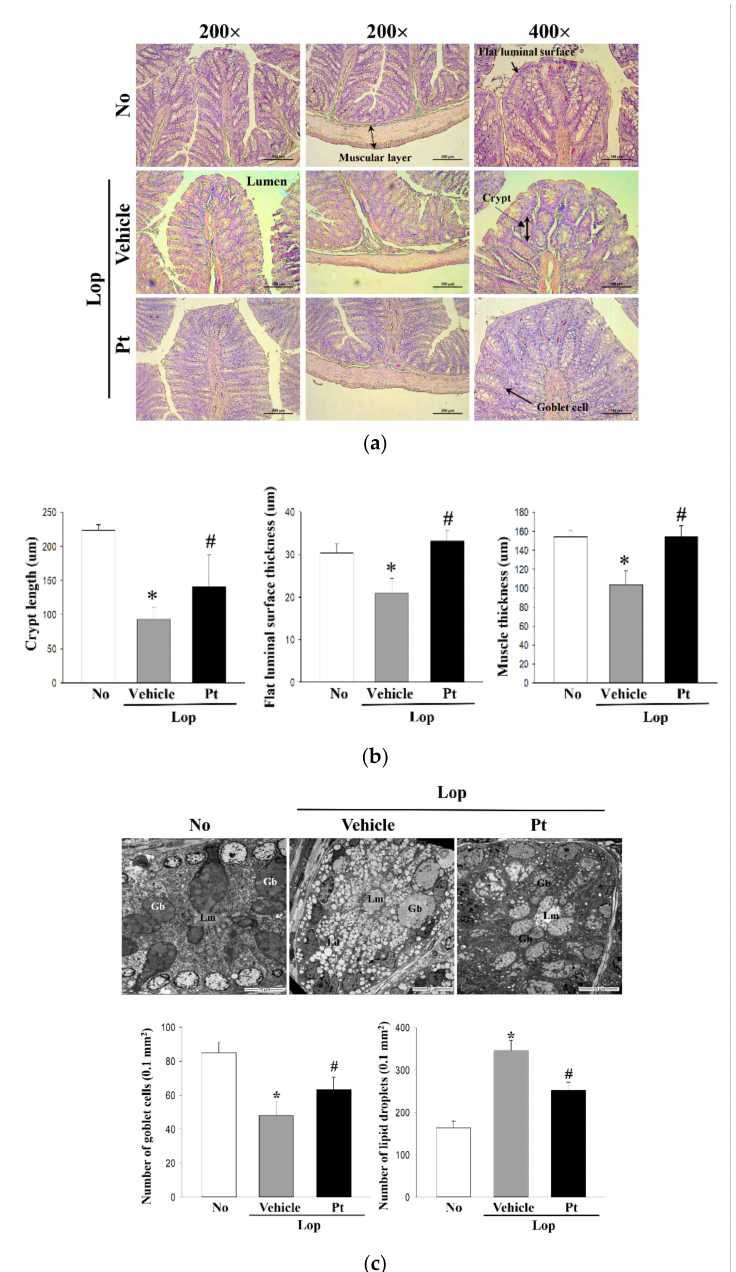
Figure 3. Histopathological and cytological structures of mid-colon in Lop+Pt-treated SD rats. ( a ) Histopathological images. H&E-stained sections of mid-colon from the subset groups were observed at 200 × and 400 × under a light microscope. ( b ) Histopathological parameters. Three parameters, namely, crypt length, flat luminal surface thickness, and muscle thickness, were measured using the Leica Application Suite. A total of 4–6 SD rats were used in the preparation of H&E-stained tissue slides in each group, and each parameter for histopathological properties was measured in duplicate in three different sites of each slide. ( c ) TEM image. Ultrastructure of the crypt in the mid-colon of subset groups was viewed by TEM at 1800 × magnification. The numbers of Paneth cells and lipid droplets were measured in extracellular matrix using the Leica Application Suite (Leica Microsystems, Switzerland). A total of 4–6 SD rats were used in the preparation of TEM samples, and the numbers of goblet cells and lipid droplets were measured in duplicate in each sample. Data are reported as the mean ± SD. *, p < 0.05 compared to the non-treated (No) group. #, p < 0.05 compared to the Lop+Vehicle-treated group. Abbreviations: Lop, loperamide; Pt,